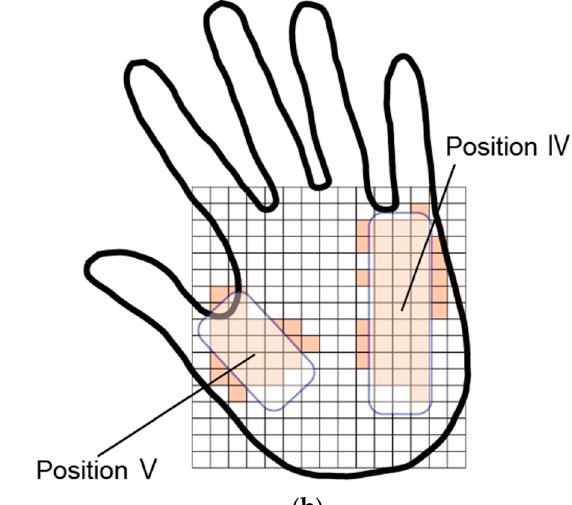
Figure 6. Normalization of palm: ( a ) Points P1–P4 and lines m and n defined on palm of hand. The angle was adjusted so that line m was horizontal. ( b ) Normalization was conducted such that the lengths of lines m and n were 500 mm and 1500 mm, respectively.